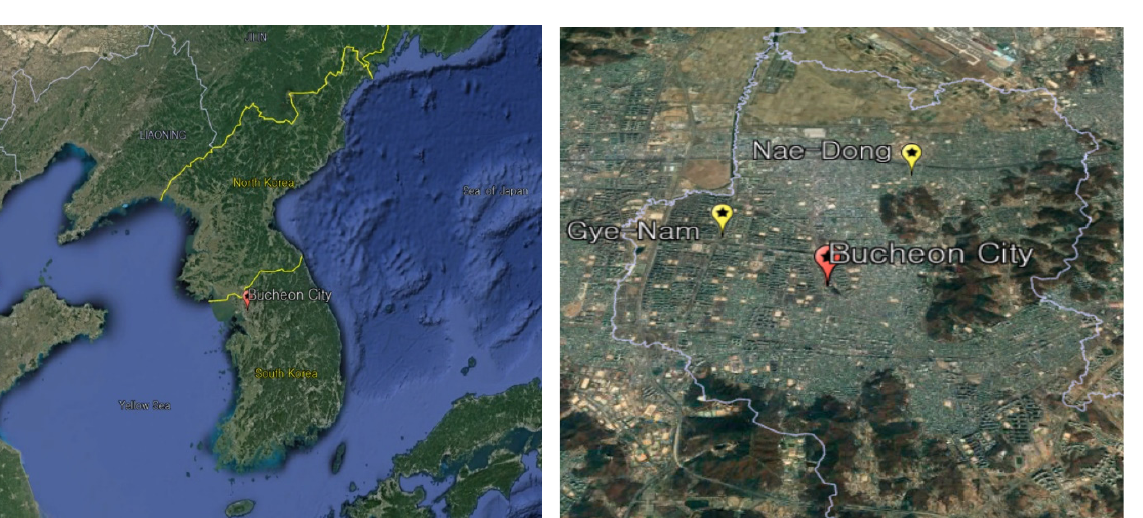
Two sampling points were selected: the Songnae-daero monitoring station (Gyenam Park) in Jung-dong and the Nae-dong monitoring station in Samjeong-dong, located approximately 2.5 km apart (Figure 1).